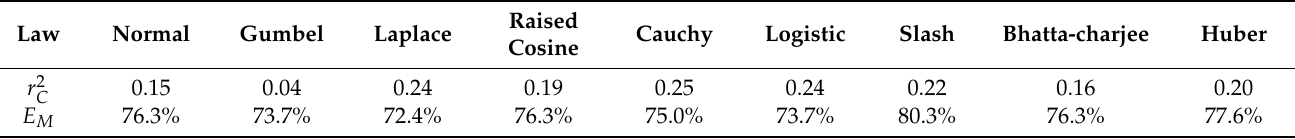
Table 8. Error margin ( E M ), and Pearson’s correlation coefficients ( r 2 C PICP calculated for each 20-cm groundwater levels having a positive